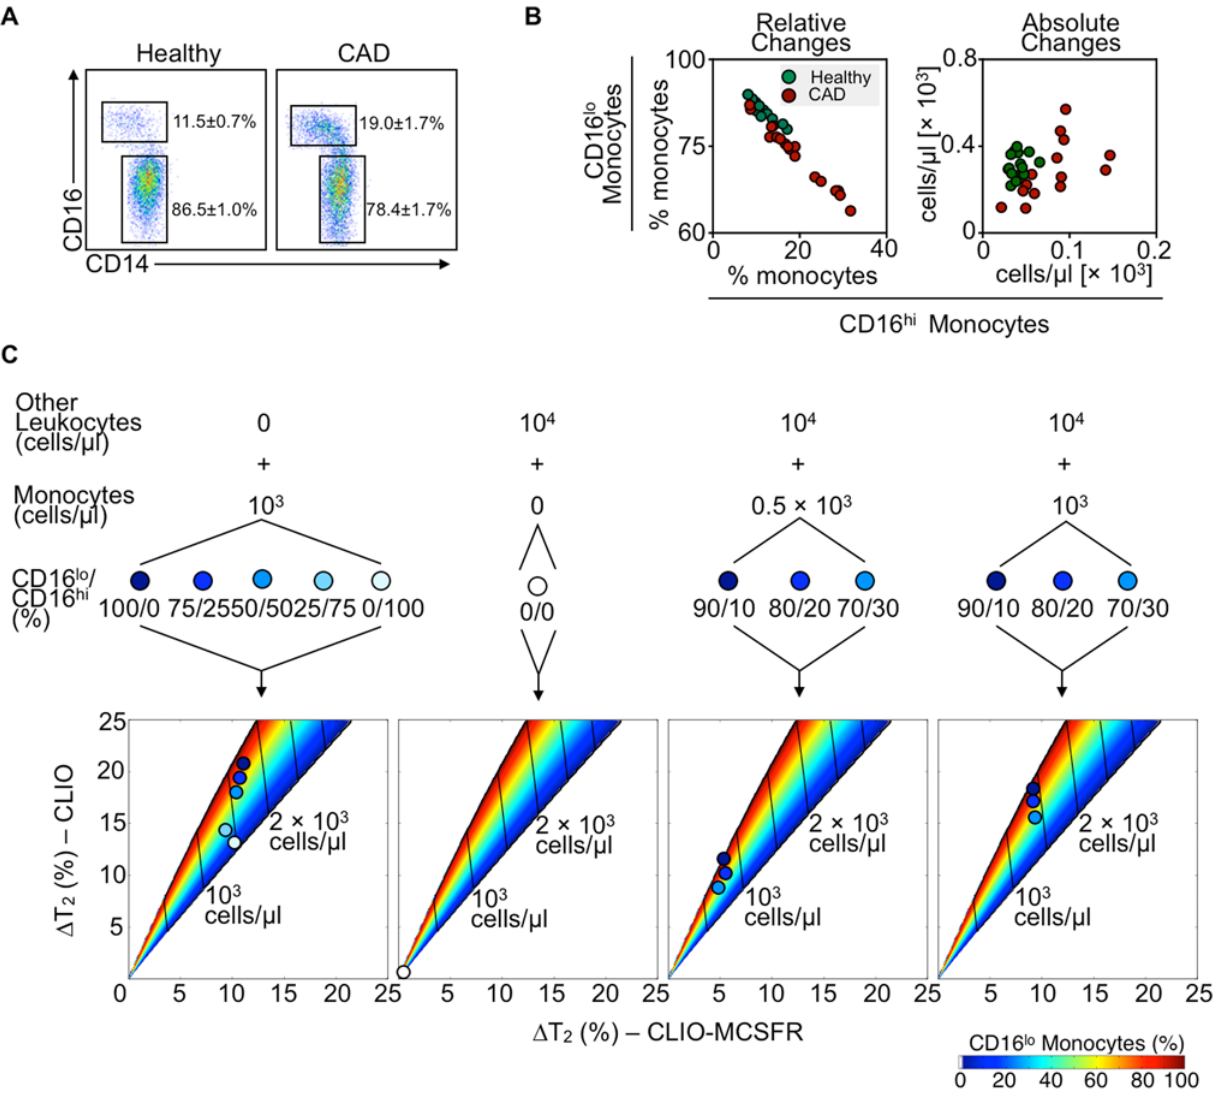
Figure 4. Magnetic nano-sensors enumerate monocyte subset variations that occur in atherosclerotic patients. A. Representative flow cytometry dot plots of monocyte subsets from healthy volunteers and patients with documented coronary artery disease (CAD). Numbers depict percentage of subsets in both groups. Mean 6 SEM. B. Plots depict percentage (left plot) and absolute numbers (right plot) of CD16 lo and CD16 hi monocytes from healthy volunteers (green dots) and patients with CAD (red dots). C. Validation of the enumerative mathematical model with varying number and percentage of monocyte subsets. Data show goodness of fit of defined numbers of monocytes alone (left panel), other leukocytes (middle-left panel) and combinations of leukocytes and monocytes (right two panels). Different proportions of monocyte subsets (CD16 lo /CD16 hi (%)) are color-coded and their fit is depicted on the two-dimensional T 2 maps.